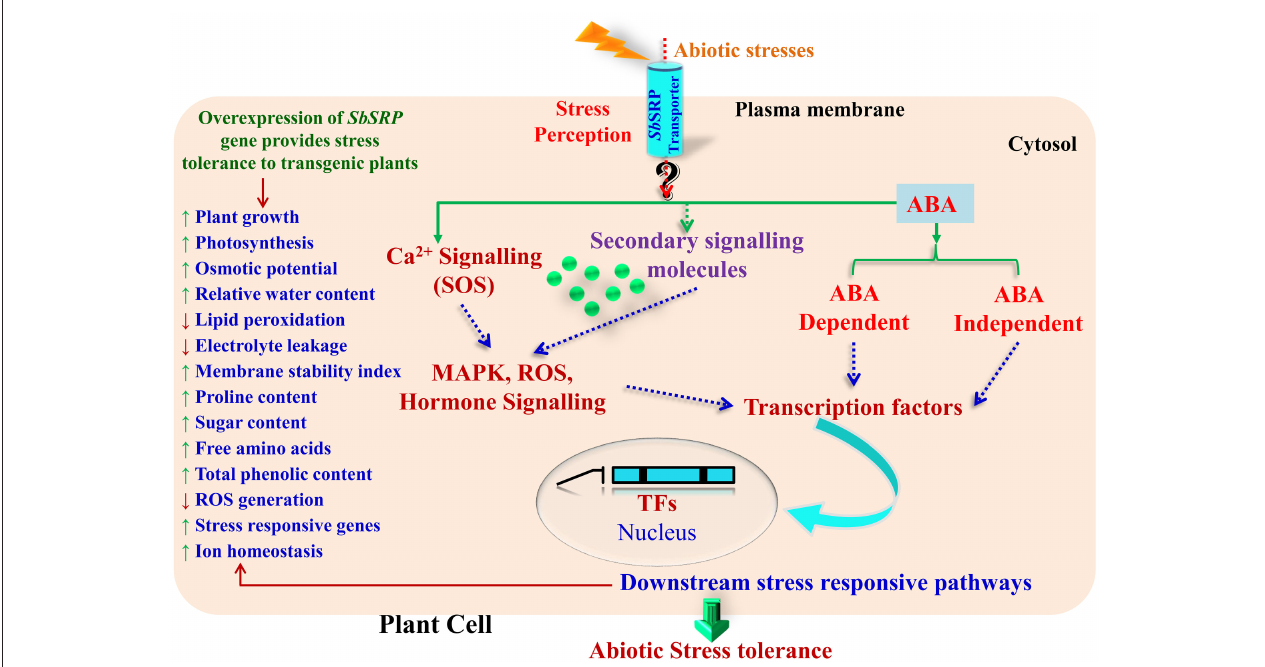
FIGURE 9 | A hypothetical model to infer the putative role of membrane bound Sb SRP-like protein in abiotic stress tolerance mechanism. The salt tolerance mechanism shown in this model is a schematic representation of a general salt tolerance mechanism (irrespective of organelle-specific) using previous